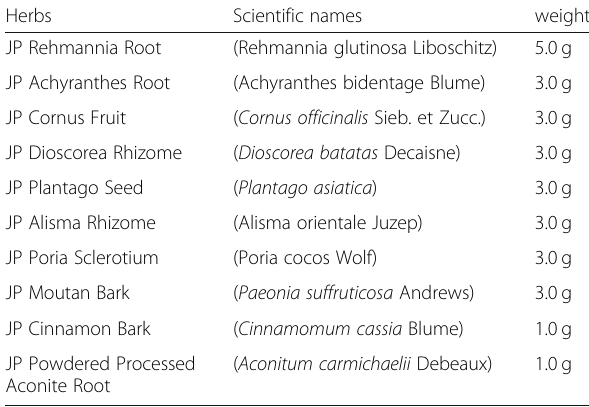
Table 1 Constituents in 7.5 g of TJ107 (JP: The Japanese Pharmacopoeia)